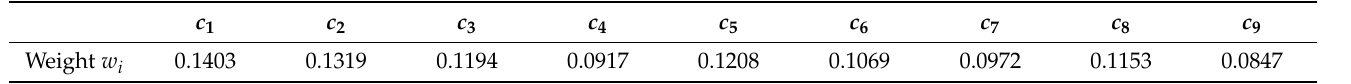
Table 5. Initial weight of characteristic quantity obtained by improved AHP